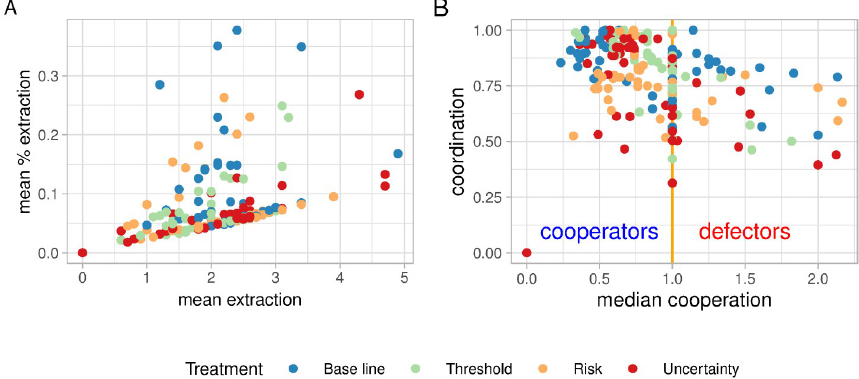
Fig 2. Fishers fish less and cooperation does not break down. Effects of treatments (threshold, risk, uncertainty) on individual extraction (top), proportion of stock (middle) and cooperation (bottom) compared to baseline (no potential for thresholds). Treatment effects are tested with a difference-in-difference random effects model with (respect to individual extraction, the proportion of the stock extracted, and cooperation (N = 4096) per response variable. Before refers to rounds before the introduction of the treatments (round 1-6) and after refers to the rounds after introduction of the treatments (round 7-16). The counterfactual is the expected response of fishers in the treatment if they would have played the baseline instead. S1-S3 Tables in S1 File complement this figure with a sensitivity analysis of robust standard error